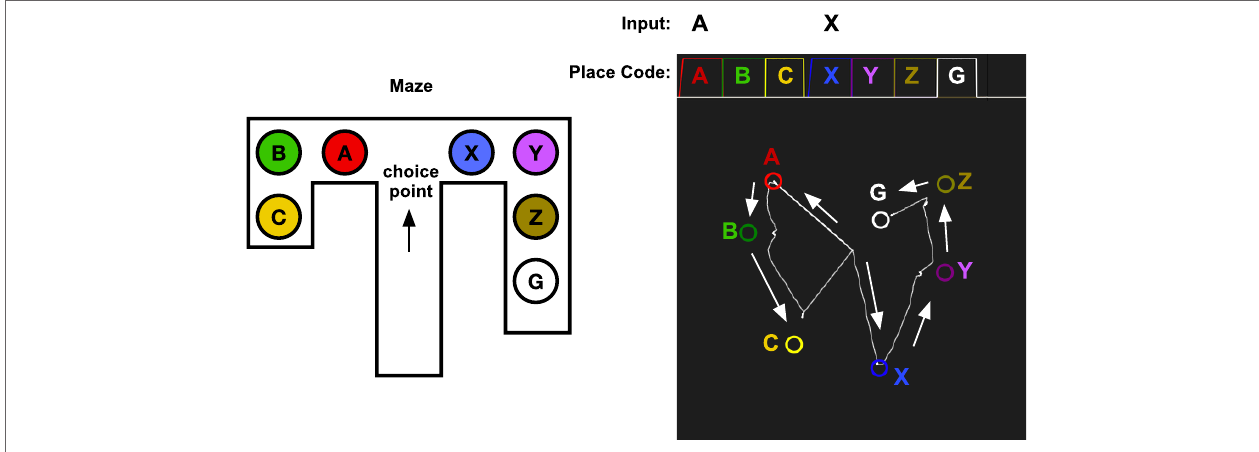
FigUre 10 | Vicarious trial and error. The memory system is assumed to have learned the sequence of places that are experienced while traveling through the maze. At the choice point, the memory system is used replay the result of choosing A or X. When looking left toward A, the memory cued with A and will start to replay A, B, C. When looking right, the memory system is cued with X which will replay the sequence X, Y, Z, G, which leads to the goal. The graph in the top right shows the activation of the place codes on the localization network. Note that the activation of A and X is slower as they are cued by an external stimulus. The graph in the bottom right shows the transitions through the identification network. The state starts at the center as A or X is received and moves through the states for the different places in the maze. The arrows show the direction of the memory